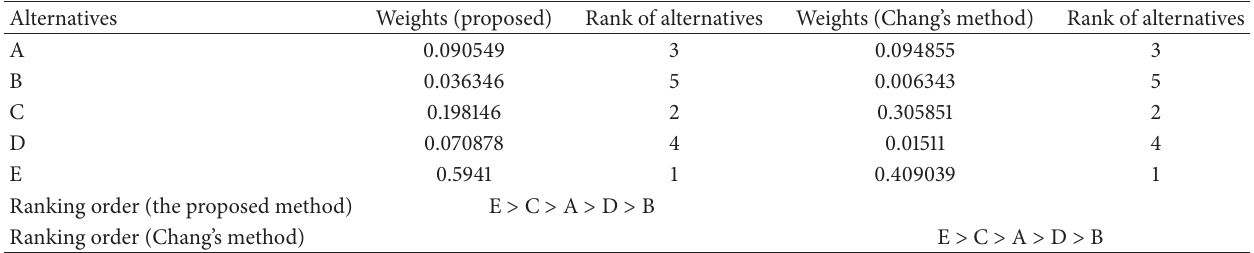
Table 22: The comparison of results of proposed method and Chang’s fuzzy AHP